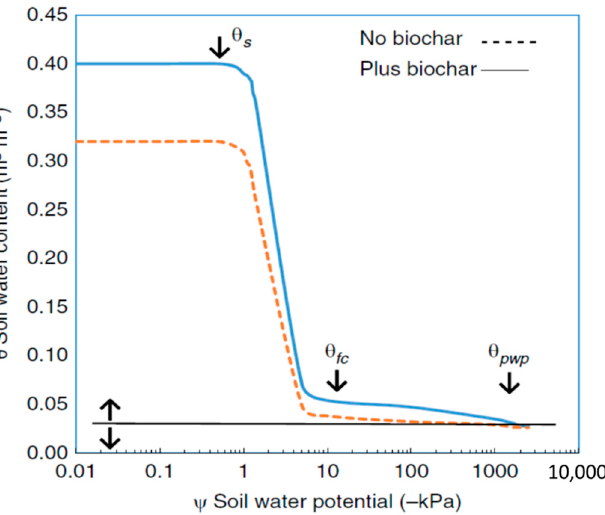
Figure 3. Relationship between soil water volumetric content ( θ ) and soil water potential ( ϕ ) [42]. Reprinted from the reference with the permission from John Wiley and Sons, copyright 2018 British Society of Soil Science.